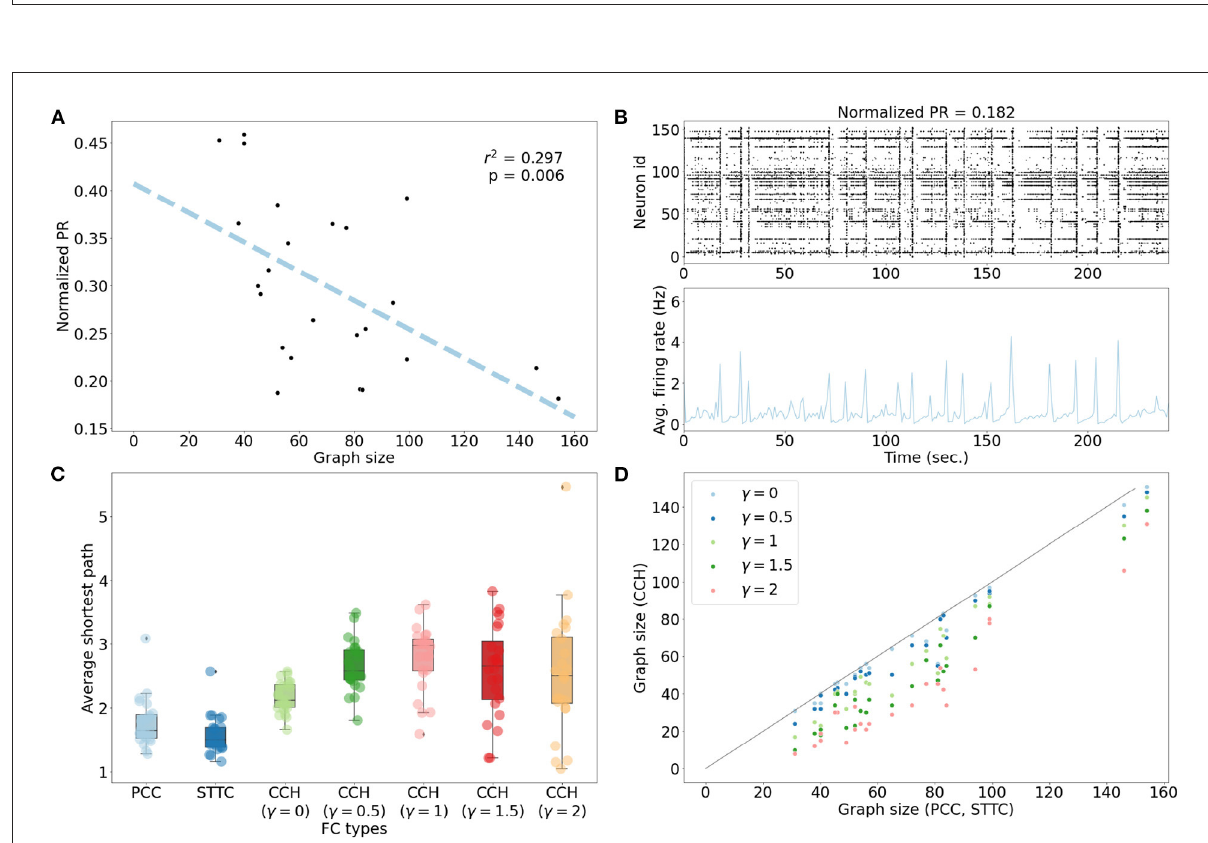
FIGURE3 Characterization of spontaneous network activity. (A) All networks showed normalized PR values of < 0.5, suggesting highly correlated network activity. There was a negative correlation between PR values and graph sizes (linear regression, r 2 = 0.297, p = 0.006). (B) Network activity plots for the network with the lowest PR value. As depicted in the raster plot, the network showed clear synchronized firing activity. (C) The distributions of average shortest path for undirected FC graphs (PCC and STTC) revealed that most networks were close to fully-connected graphs featuring an average shortest path length of 1.765 ± 0.371 ( µ ± σ ) in PCC and 1.576 ± 0.288 in STTC. The directed FC graphs (CCH) showed longer average shortest paths: 2.162 ± 0.232 ( γ = 0), 2.653 ± 0.39 ( γ = 0.5), 2.784 ± 0.499 ( γ = 1), 2.581 ± 0.704 ( γ = 1.5), and 2.534 ± 0.943 ( γ = 2). (D) The viable directed FC graphs derived from CCHs were smaller in comparison to the undirected FC graphs (PCC and STTC) for all γ